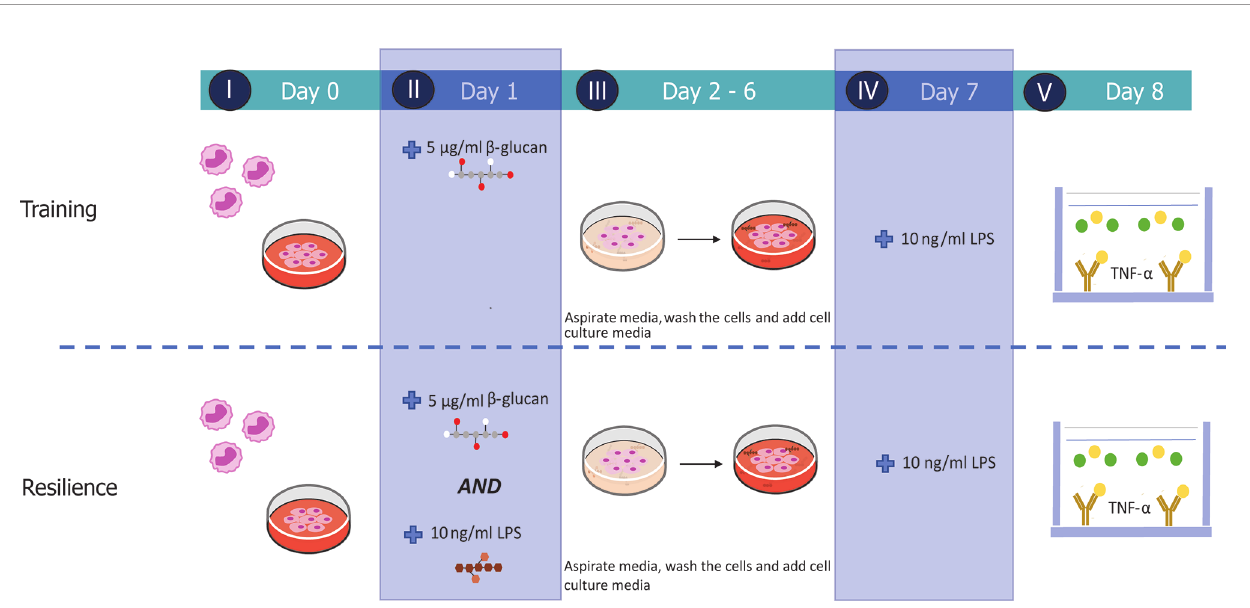
FIGURE 1 | Experimental set-up of the established in vitro training and resilience protocols. Monocytes were retrieved from cryogenic vials and allowed to settle for 24 h (I) before cells were stimulated with medium, 5 µg/ml b -glucan (yeast-b, yWGP, grifolan), 10 ng/ml LPS or both b -glucan and LPS for 24 h (II). Stimuli were removed and cells were rested for 5 days (III) and subsequently challenged at day 7 with 10 ng/ml LPS (IV). Supernatant was collected on day 8 to quantify TNF- a levels measured by means of ELISA